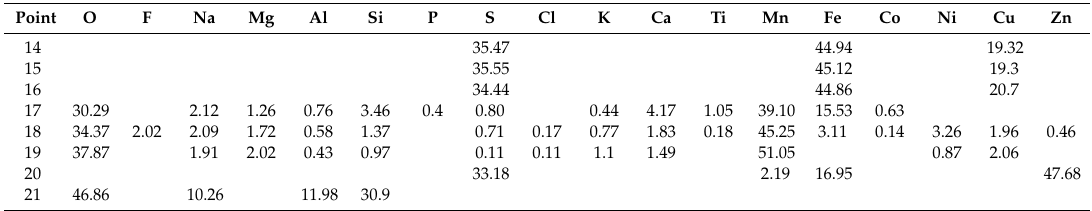
Figure 2. Scanning electron microscope (SEM) ( a , c ) images and energy dispersive spectroscopy (EDS) analyses ( b , d ) with displayed distribution of selected elements. ( a , b ) Isocubanite with lamellae of chalcopyrite, ( c , d ) heterogeneous layer growth structure of nodules. Table 1. EDS analyses (in %) on selected particles of a mixture of PN (67%) and SMS (33%). Point locations are indicated in Figure 1. Points 14–16 represent isocubanite with lamellae of chalcopyrite, point 20 is sphalerite with a high concentration of Fe, points 17–19, 21 are from heterogeneous layer growth structure of nodules.